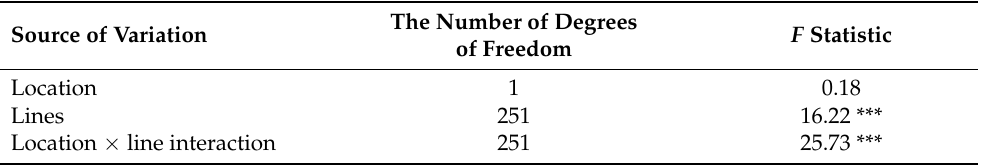
The Number of Degrees F Statistic of Freedom